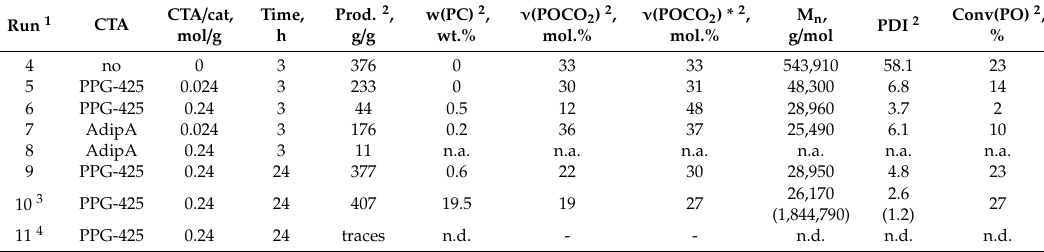
Table 3. Results of CO 2 / PO copolymerization in the presence of PPG-425 or adipic acid (AdipA). Run